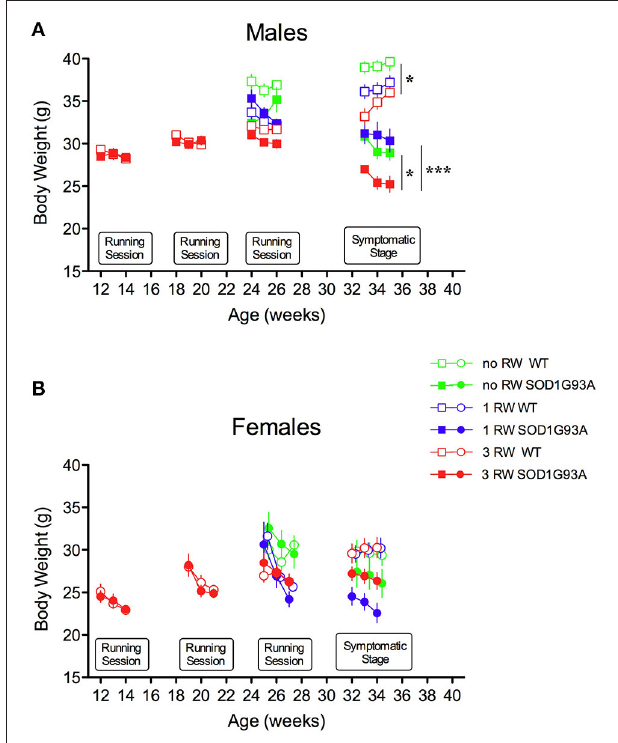
FIGURE 2 | Effect of running wheel exercise on body weight. (A) Effect of exercise on body weight of male mice during running sessions and at symptomatic stage. ANOVA, Running session at 24–26 weeks: Genotype effect, F (1,47) = 4.69, P = 0.035; Exercise effect, F (2,47) = 12.53, P < 0.0001, Genotype × Exercise, F (2,47) = 4.853, P = 0.012. ANOVA, Symptomatic stage (age 32–34 weeks): Genotype effect F (1,49) = 120.3, P < 0.0001; Exercise effect F (2,49) = 10.74, P = 0.0001. n = 8–10 per group. * P < 0.05 no RW vs. 3 RW in WT and SOD1G93A low-copy mice, *** P < 0.001 1 RW vs. 3 RW in SOD1G93A low-copy mice, Bonferroni post-hoc test. (B) Effect of exercise on body weight of female mice during running sessions and at symptomatic stage. ANOVA, Running session at 24–26 weeks: Exercise effect, F (2,43) = 4.446, P = 0.017. ANOVA, Symptomatic stage (age 32–34 weeks): Genotype effect, F (1,43) = 17.18, P = 0.0002. n = 6–10 per group.